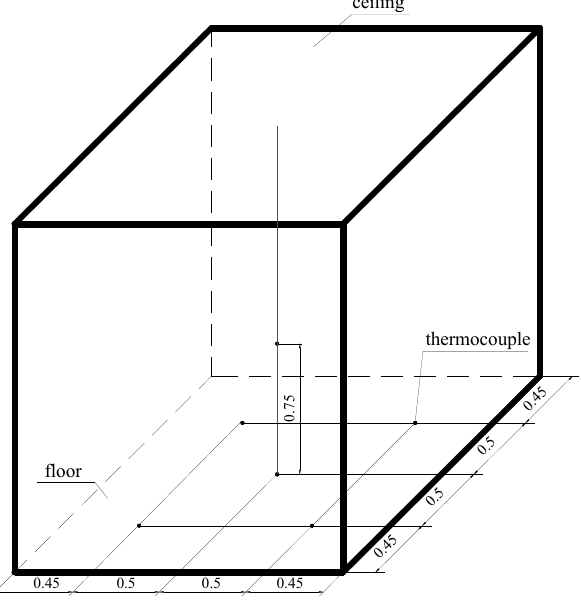
Figure 5. Layout diagrams of the measurement locations in the indoor environmental chamber.